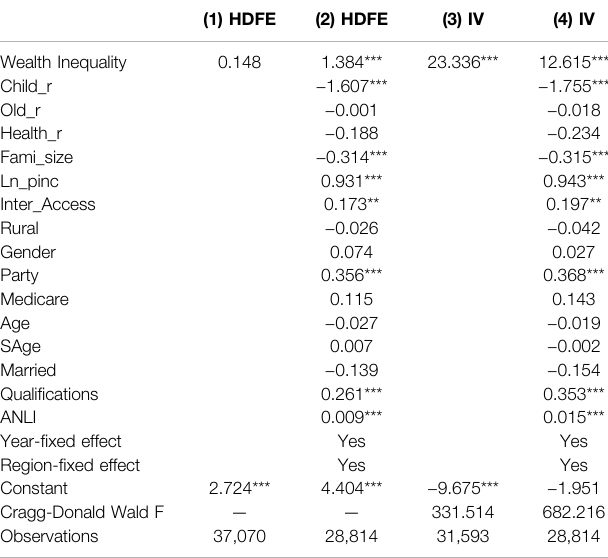
TABLE 3| Estimation results: HDFE and IV regression for HCEs_ total during 2014-